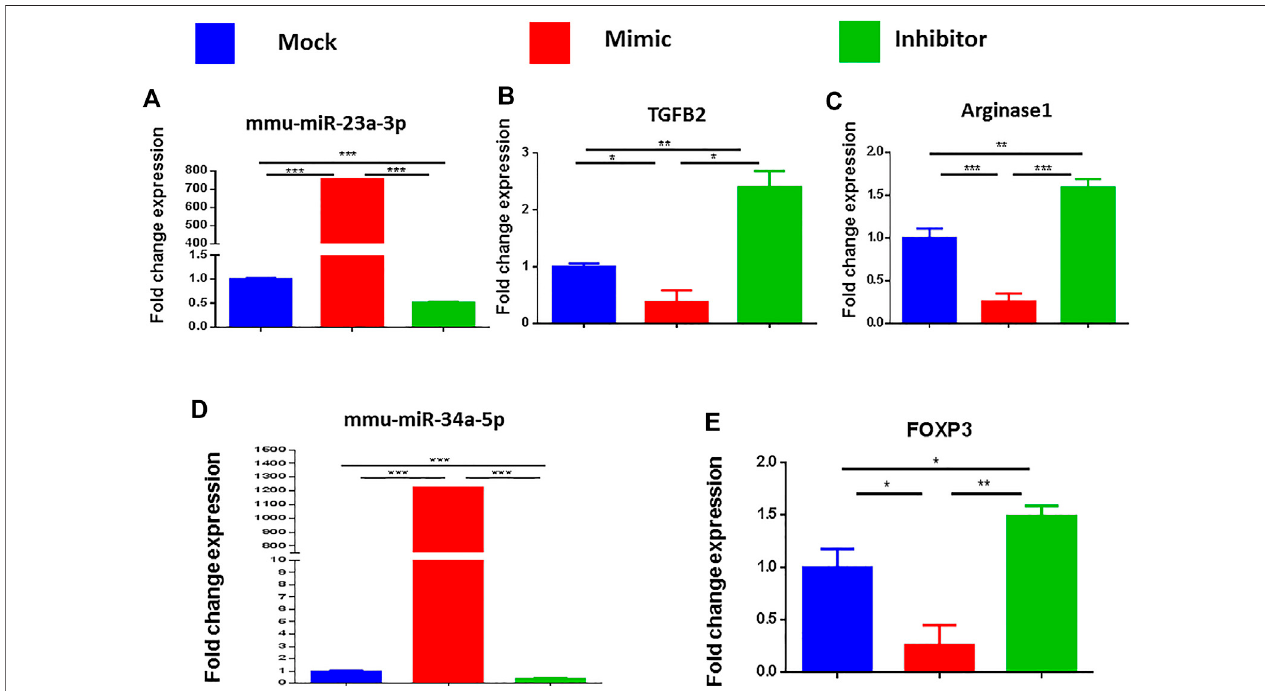
FIGURE7| Validationofthegenestargeted by miRNA 23a-3pand miRNA34a-5p. Splenocytes ofC57BL6mice, cultured and activated withSEB overnightwere transfected with mock, mimic and inhibitor of each of miRNA 23a-3p and miRNA 34a-5p. qRT-PCR was used to detect the levels of targeted genes . (A) Expression of miRNA23a-3p. (B) ExpressionofTGFB2gene. (C) Expressionofarginaseonegene (D) ExpressionofmiRNA34a-5p. (E) ExpressionofFOXP3.Statisticalsigni fi cances as p ≤ 0. 05, ** p ≤ 0. 01, *** p ≤ 0. 001.